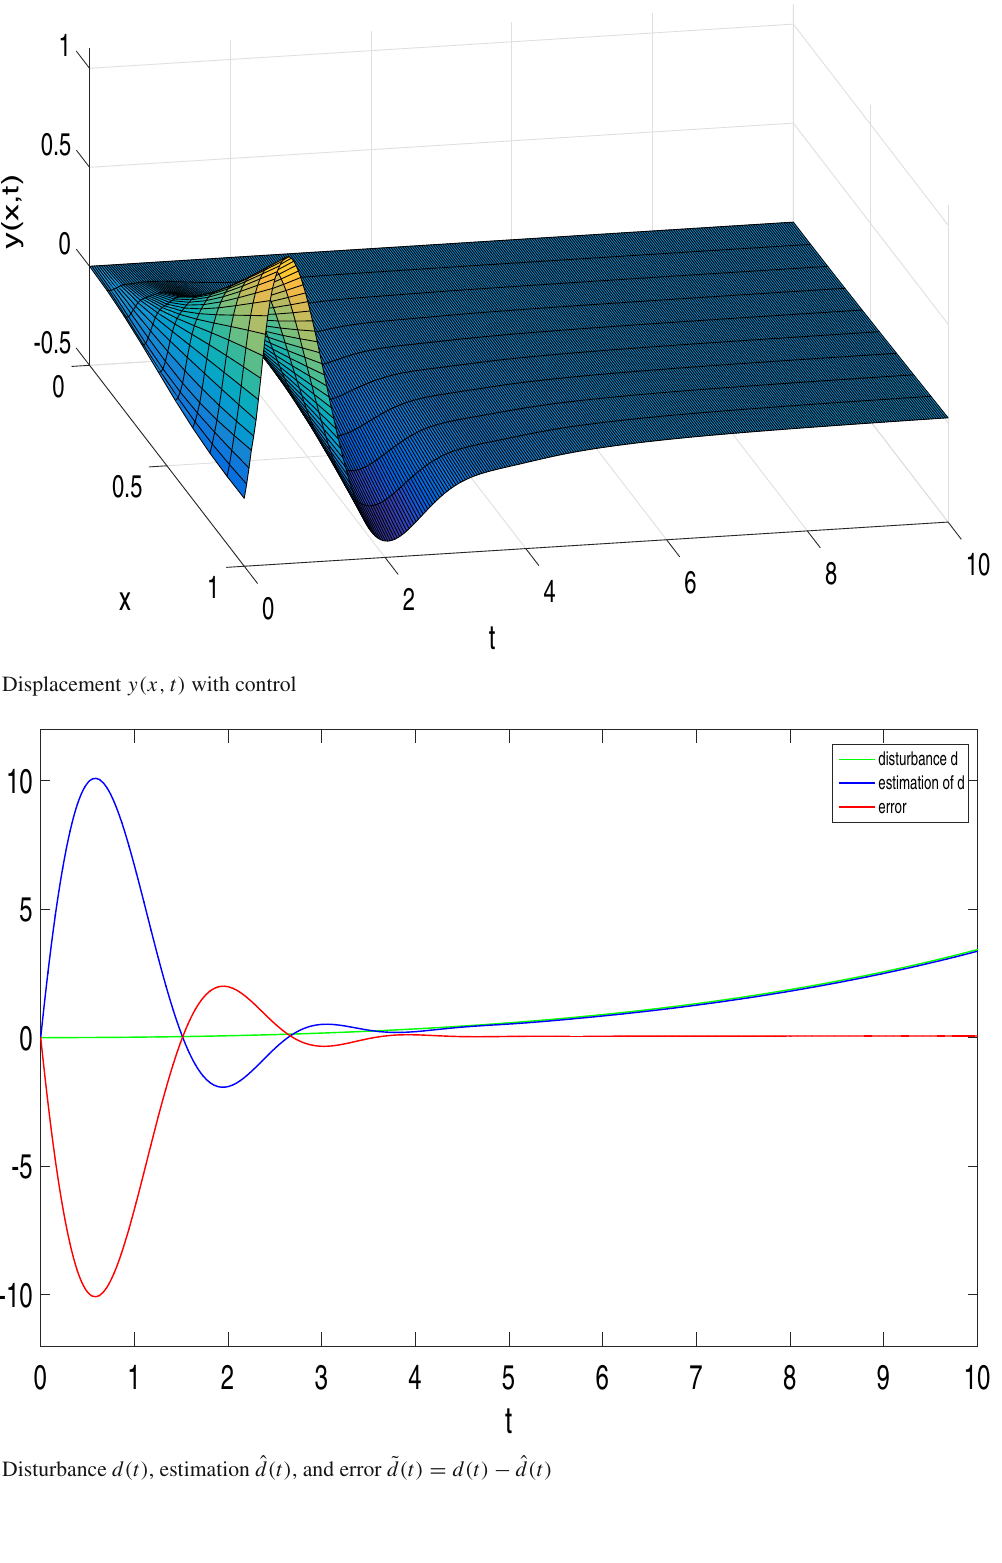
Fig. 4 Disturbance d ( t ) , estimation ˆ d ( t ) , and error ˜ d ( t ) = d ( t ) − ˆ d ( t